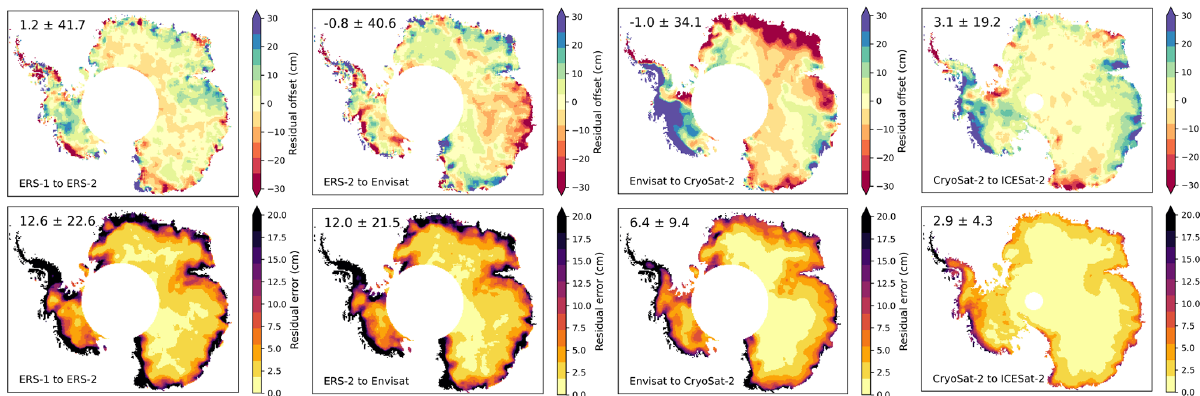
Figure 4. Maps of the residual cross-calibration offset and the corresponding error for the three main intermission transition periods. One should note that here ICESat has been grouped with Envisat in the initial calibration.